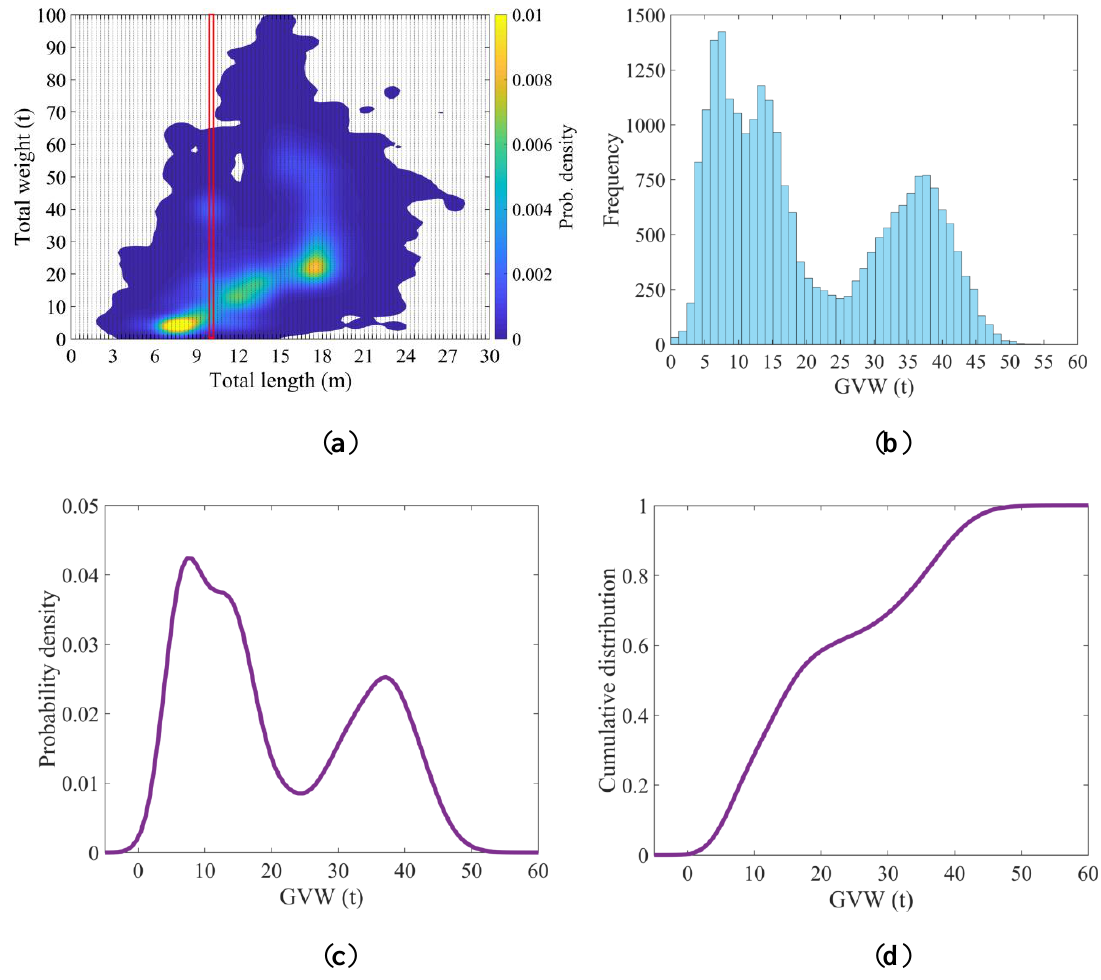
Figure 3. Weight inference process illustrated with one month of slow lane vehicle weights: ( a ) Contours of relative frequency of weight / length combinations; ( b ) Gross weight (GVW) histogram for segment 34 (9.90–10.20 m); ( c ) Fitted probability density function; ( d ) Cumulative distribution function.